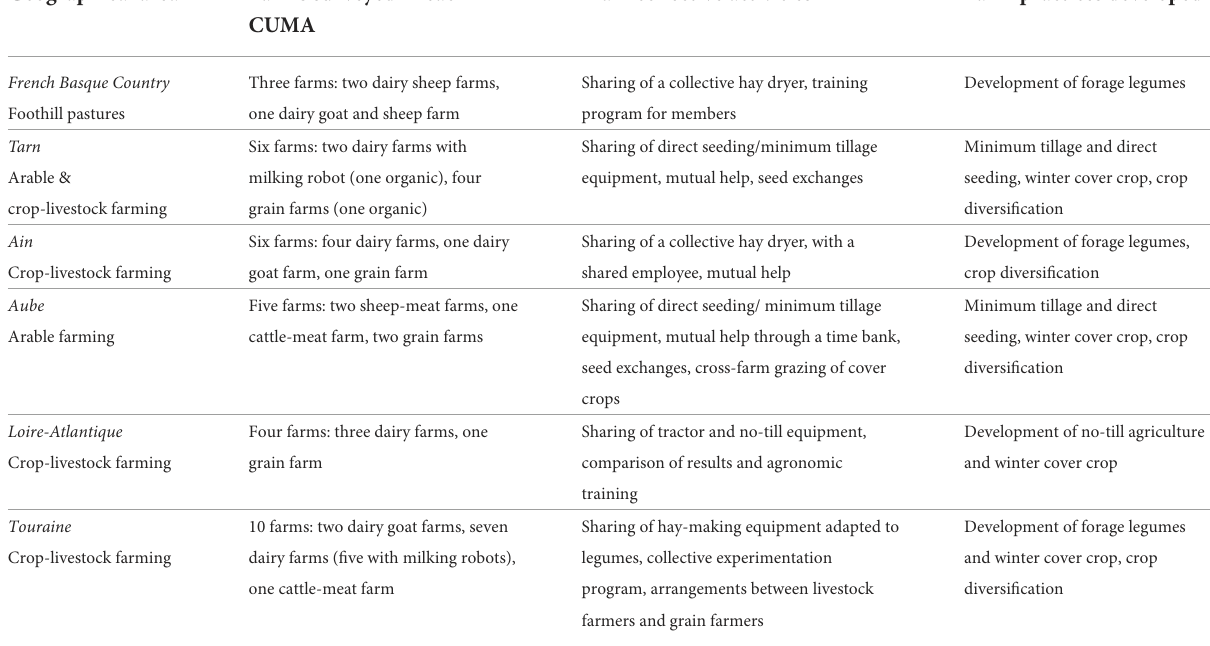
TABLE 1 Characteristics of the CUMAs surveyed. Geographical